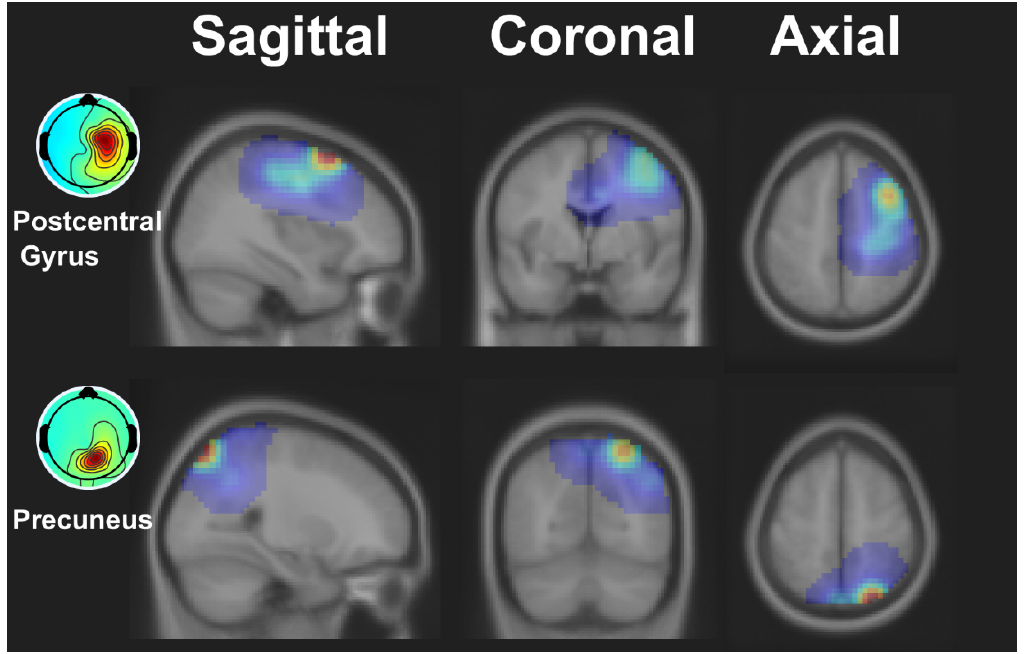
Figure 2. Dipole densities of clusters showing significant differences between conditions. The mean Montreal Neurological Institute (MNI) coordinate of the first cluster was (35 0 52), and the estimated location was the postcentral gyrus, with a probability of 17.9%. The mean MNI coordinate of the second cluster was (26 − 69 55), and the estimated location was the precuneus, with a probability of 22.5%.